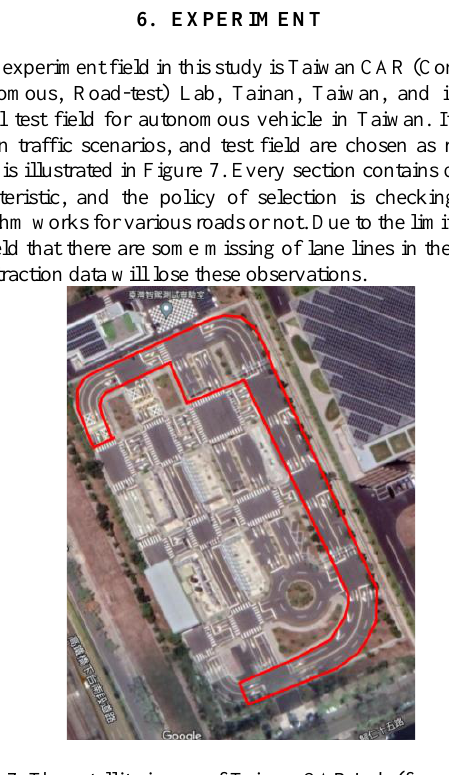
Figure 7. The satellite image of Taiwan CAR Lab (from Google Map). The red mark parts are the road sections that is chosen as